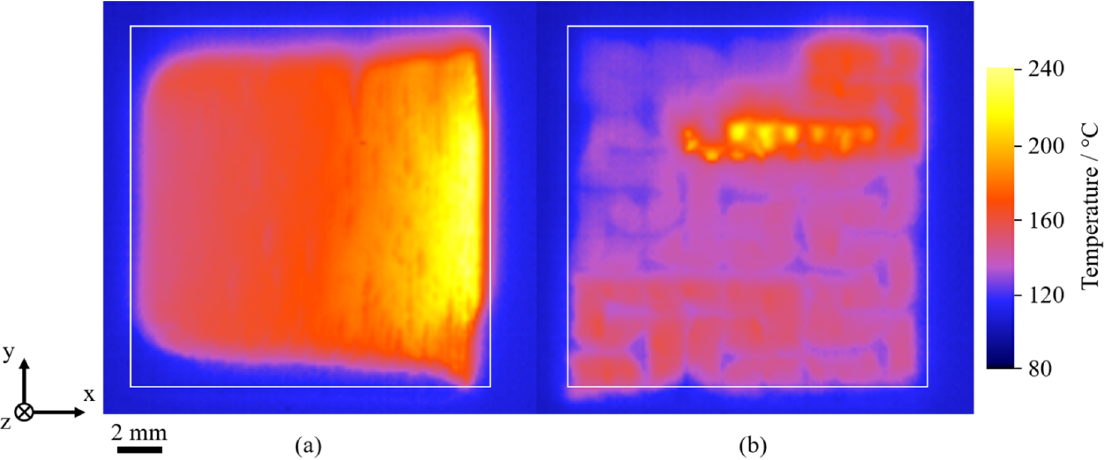
Figure 6. Thermographic imaging of the spatial distortion of the single-scan meander strategy ( a ) and the fractal Peano strategy ( b ) at a powder bed temperature of 100 °C, specified geometry indicated by a white square.